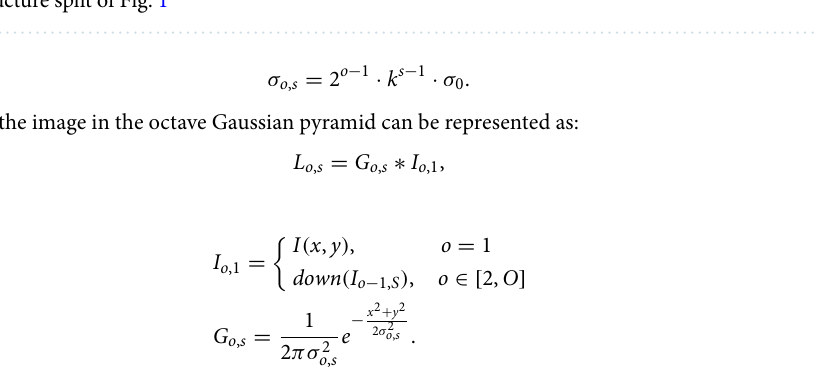
Figure 2. Structure split of Fig.